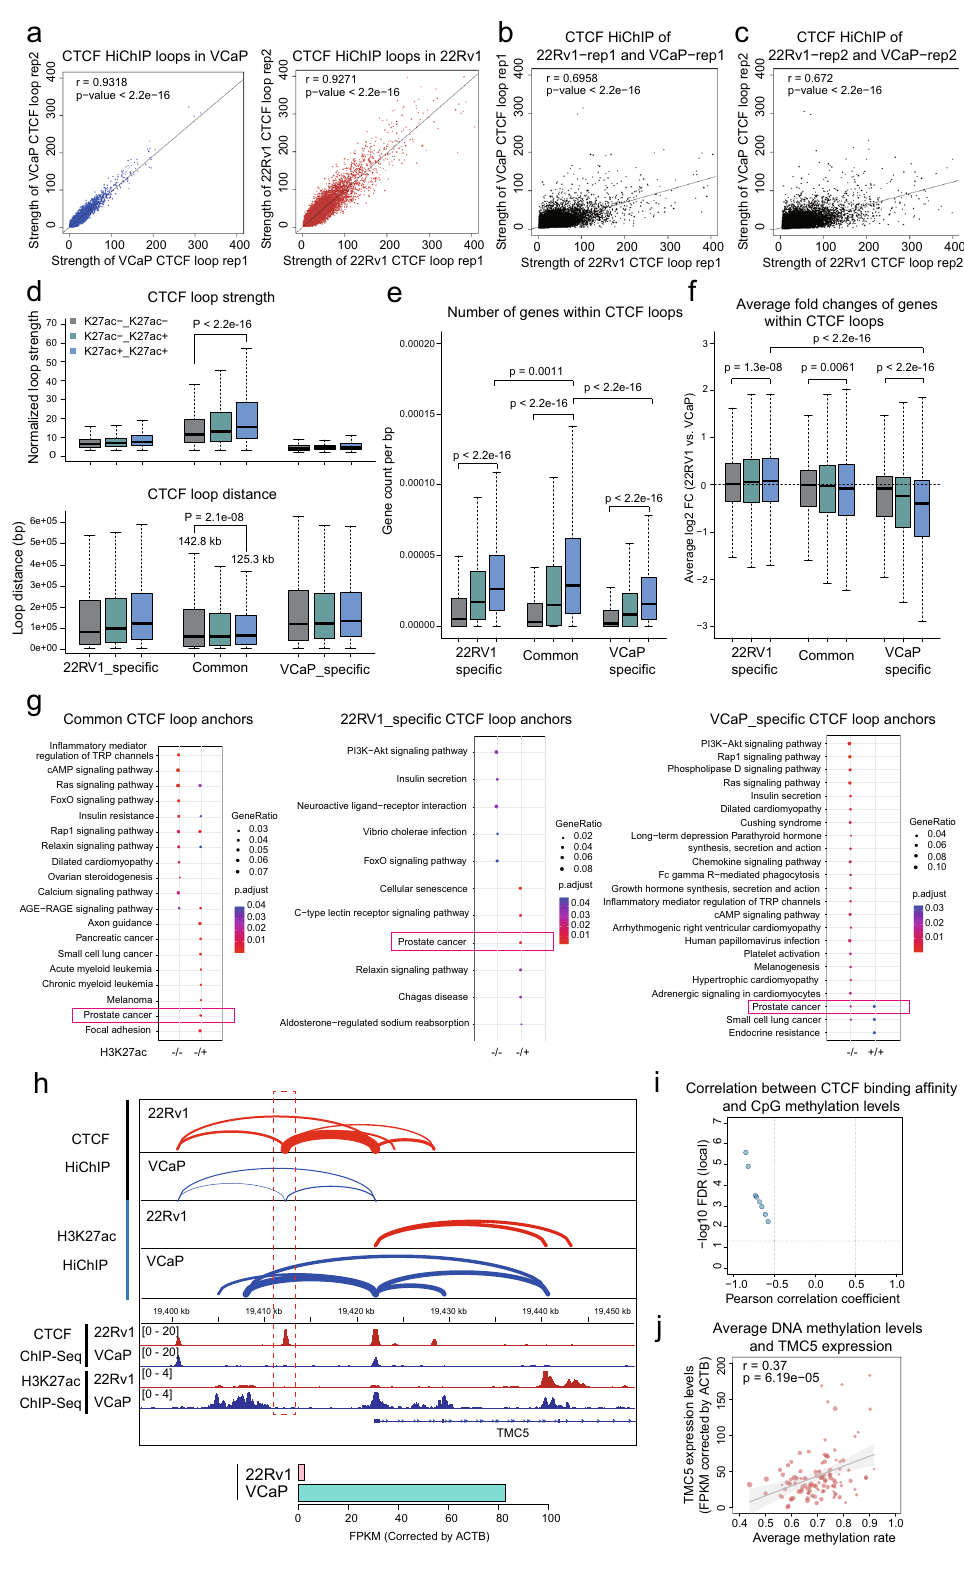
Pearson correlation coefficient Average DNA methylation levels and TMC5 expression